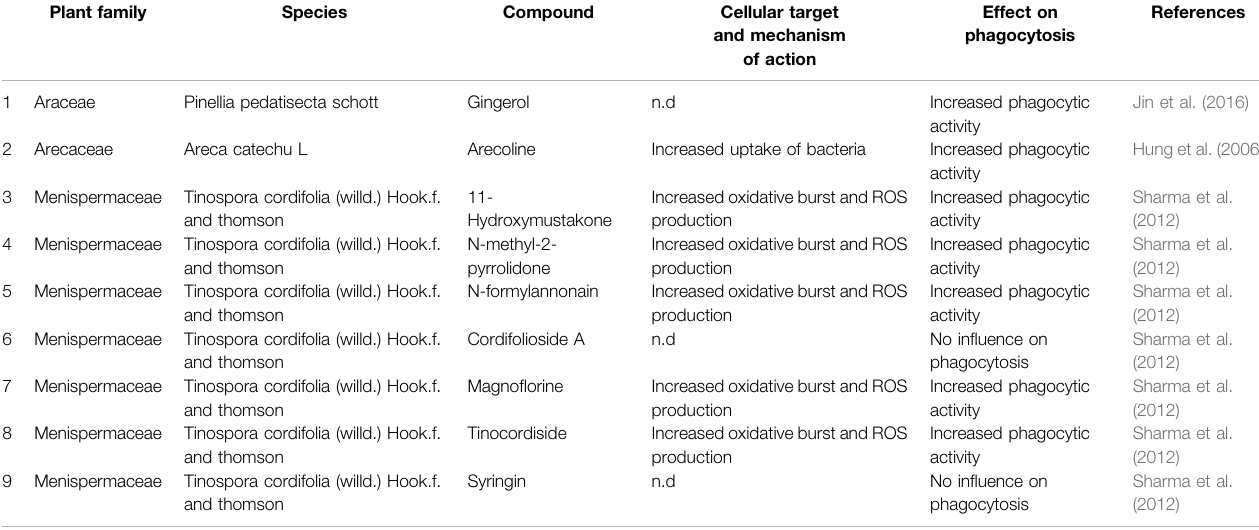
TABLE 2 | List of selected compounds isolated from plant material with documented impact on phagocytosis. Plant family